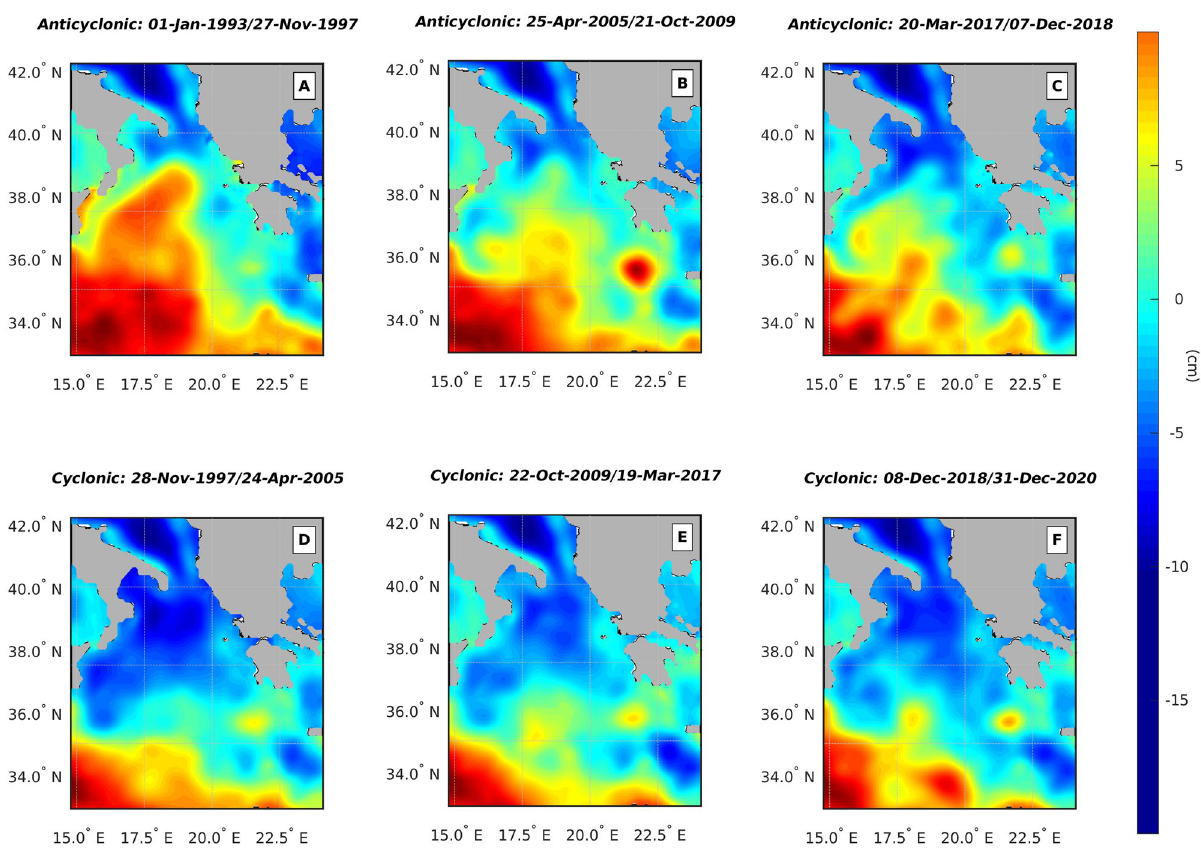
Figure 3. Average SSH over the anticyclonic ( A-C ) and cyclonic periods ( D-F ). This figure has been created using MATLAB software package version 2018a (www. mathw orks.